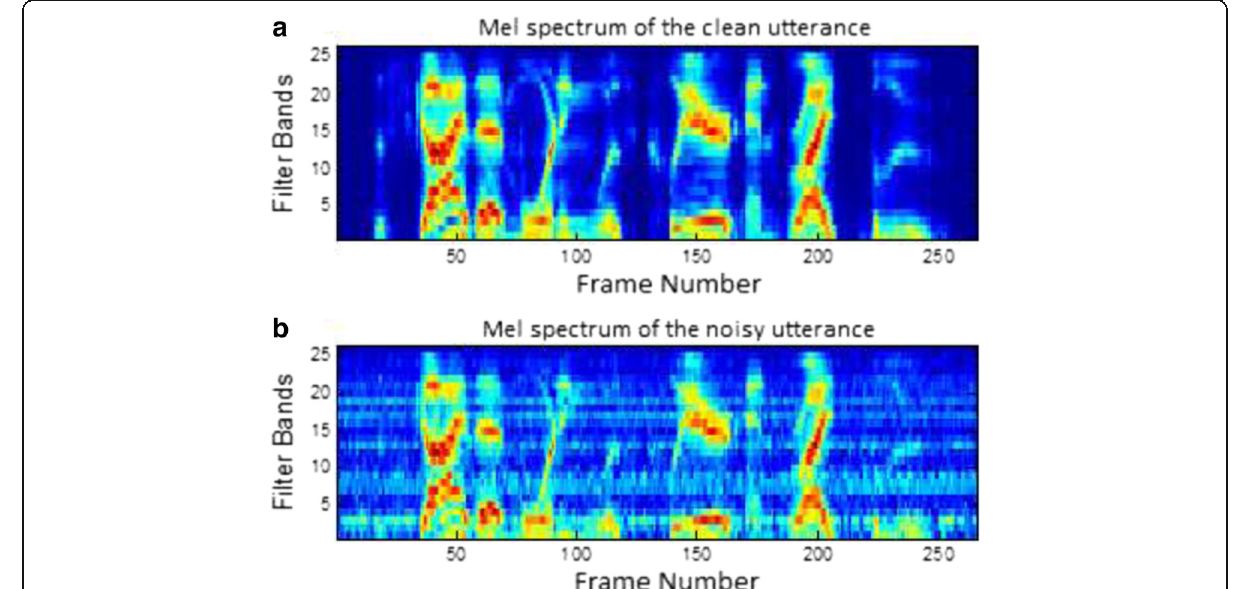
Fig. 1 Mel spectra of the a clean signal and b the noisy signal with a 5 dB overall